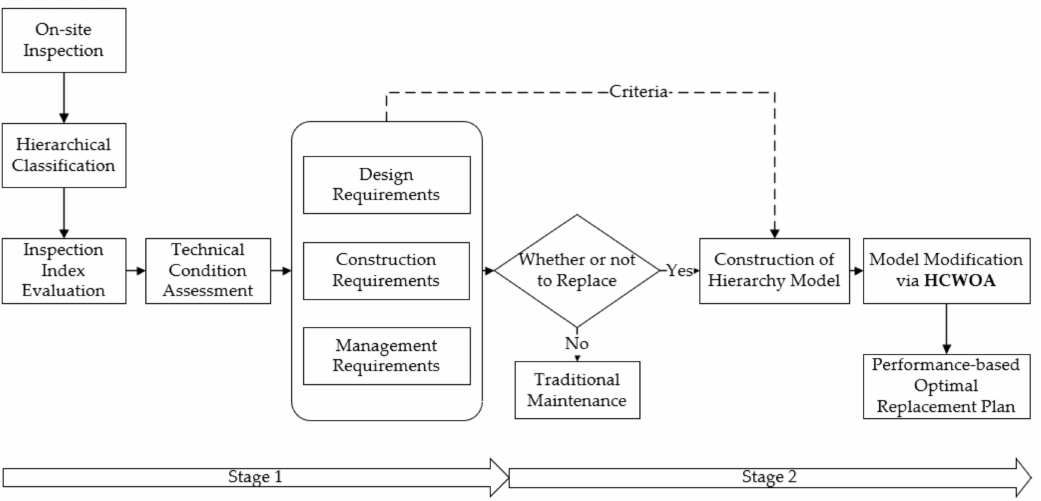
Figure 1. Framework of improved BECI replacement decision